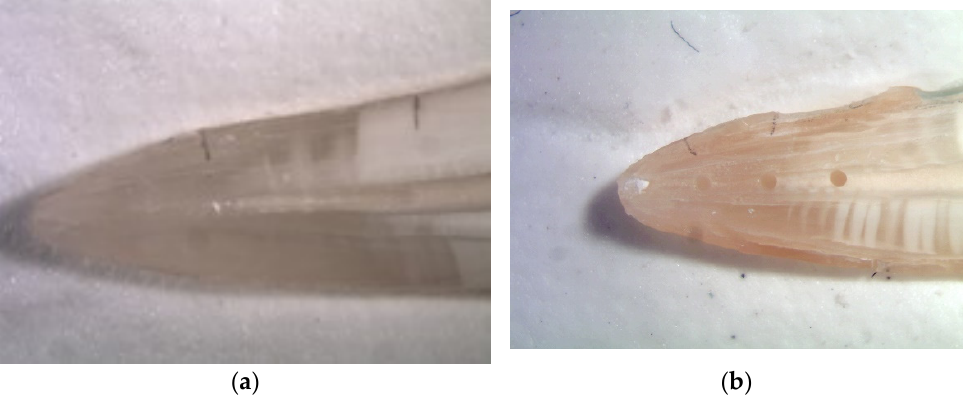
Figure 1. ( a ) Groove prepared into one half of the split root; ( b ) Three holes prepared into the other half of the split